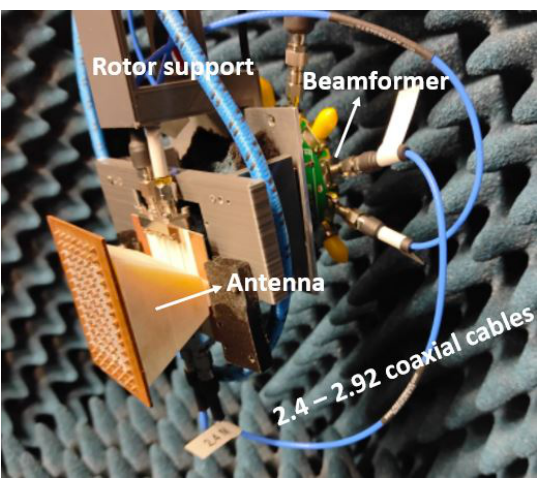
Figure 8. Entire manufactured phased array connected with the beamformer and ready to be measured in the anechoic